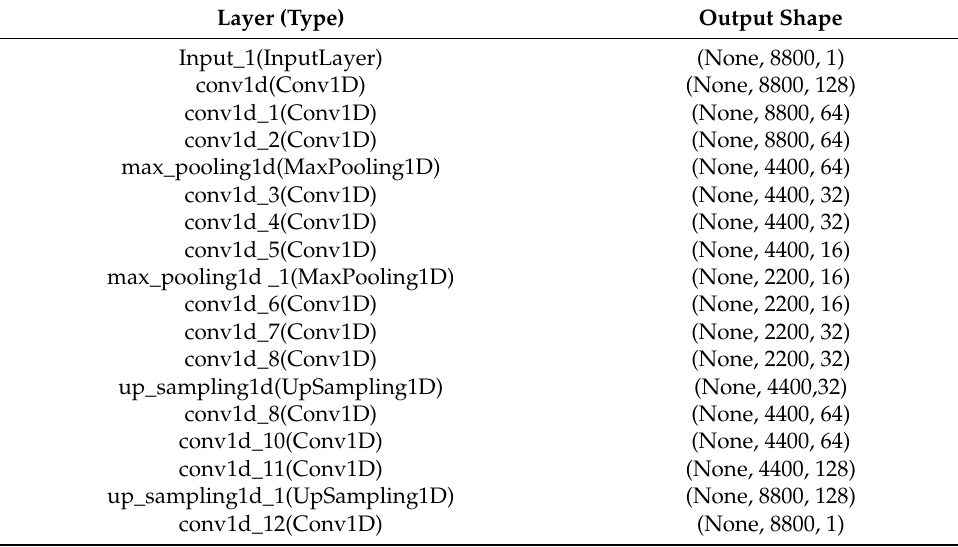
Table 4. The parameters of CAENN